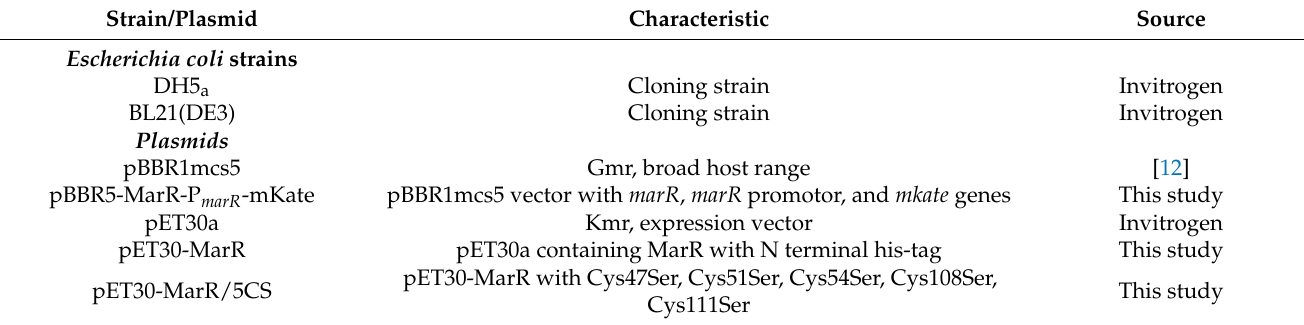
Table 1. Strains and plasmids used in this